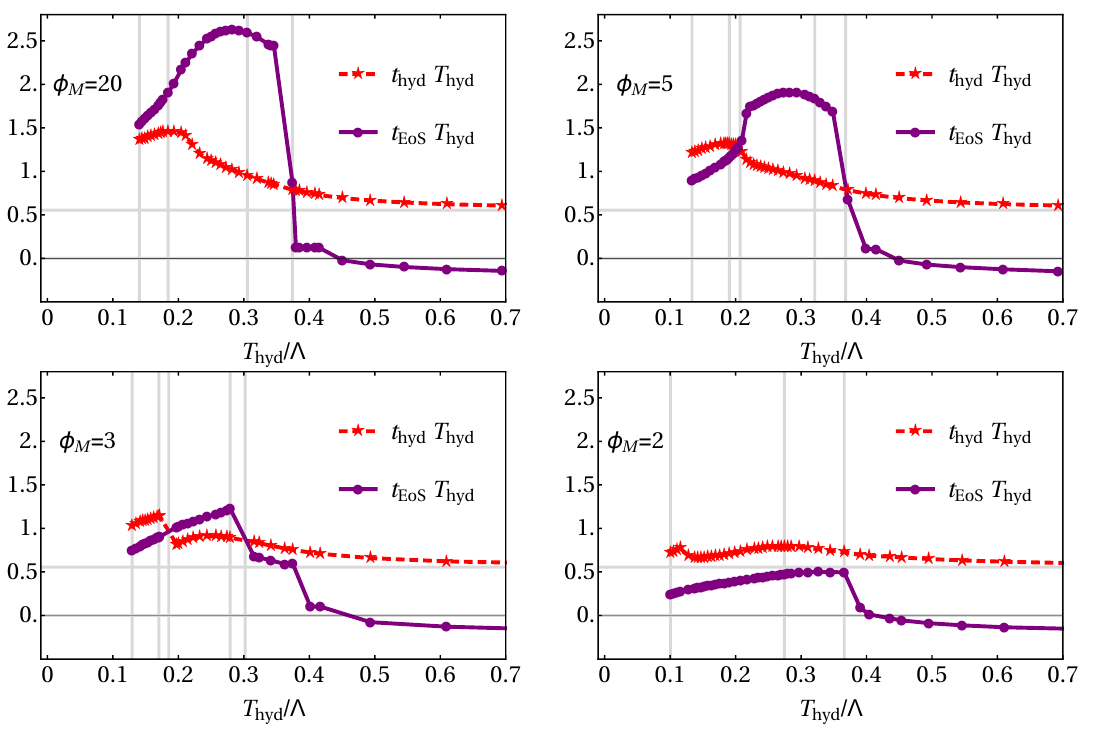
Figure 8 . Hydrodynamization and EoSization times as a function of the hydrodynamization temperature for collisions of shocks with (cid:22)! = 0 : 32 for (cid:30) = f 20 ; 5 ; 3 ; 2 g . The horizontal grey line M lies at t hyd T hyd = 0 : 56 and corresponds to the conformal limit of the 1 = 2 shocks. From left to right, the (cid:12)rst three vertical grey lines indicate the hydrodynamization temperatures for the collisions with the minimal value of T hyd = (cid:3), the maximum value of t hyd T hyd , and the maximum value of the ratio t EoS =t hyd . The rightmost vertical grey line indicates the high-temperature crossing at which t EoS = t hyd . The temperatures and the values of the (cid:16)=(cid:17) ratio at these vertical lines for each value of (cid:30) M is as follows. For (cid:30) M = 20 we have T hyd = (cid:3) = f 0 : 141 ; 0 : 184 ; 0 : 346 ; 0 : 374 g